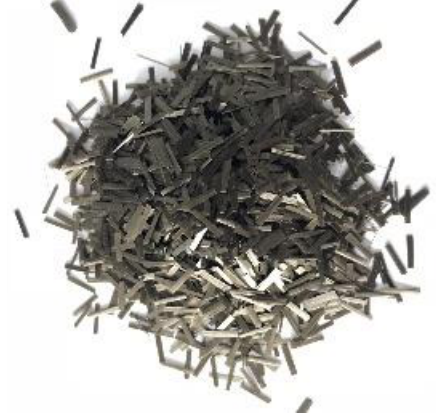
Figure 1. Macro image of basalt fiber.